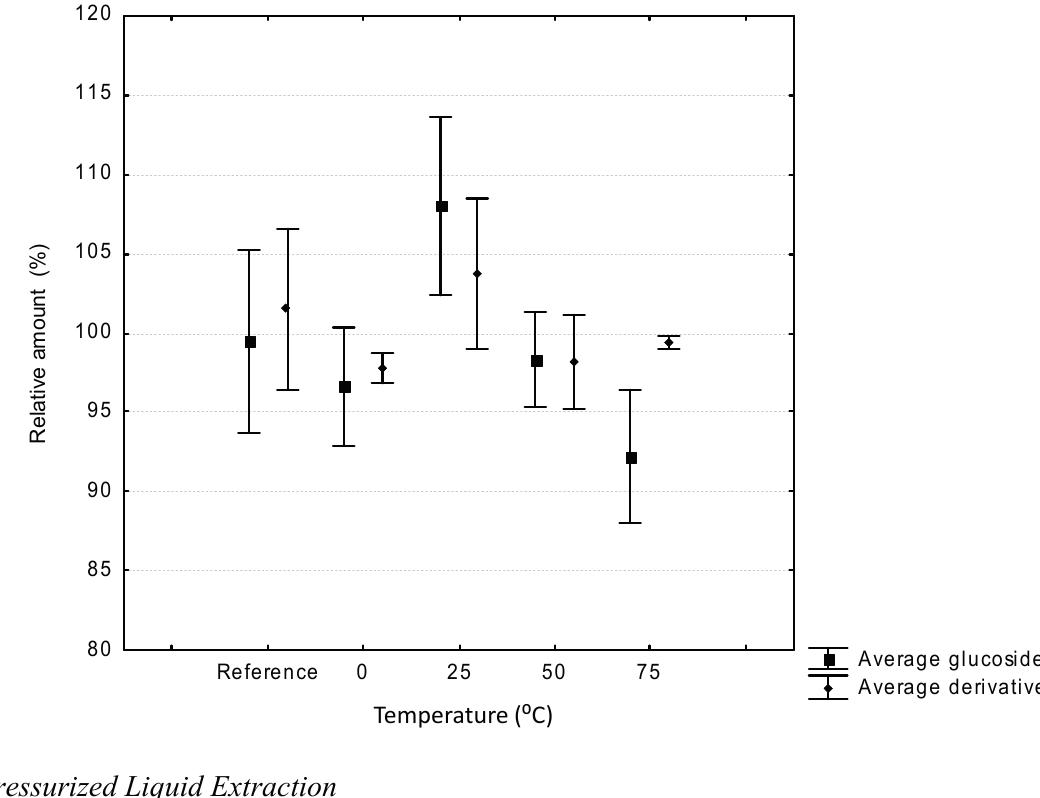
Figure 1. Average recoveries (mean ± standard deviation) of anthocyanins at different working temperatures (0, 25, 50 and 75 °C) and the reference in the ultrasound-assisted extraction